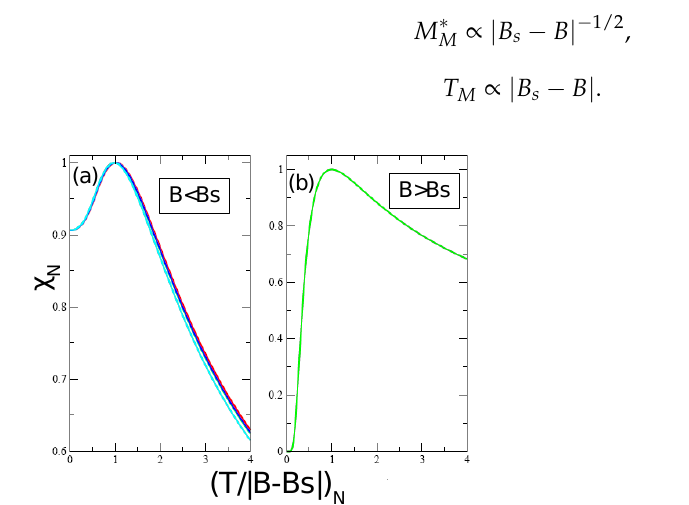
) N , calculated B B s | − | 0. Two different curves on panel ( a ) show →